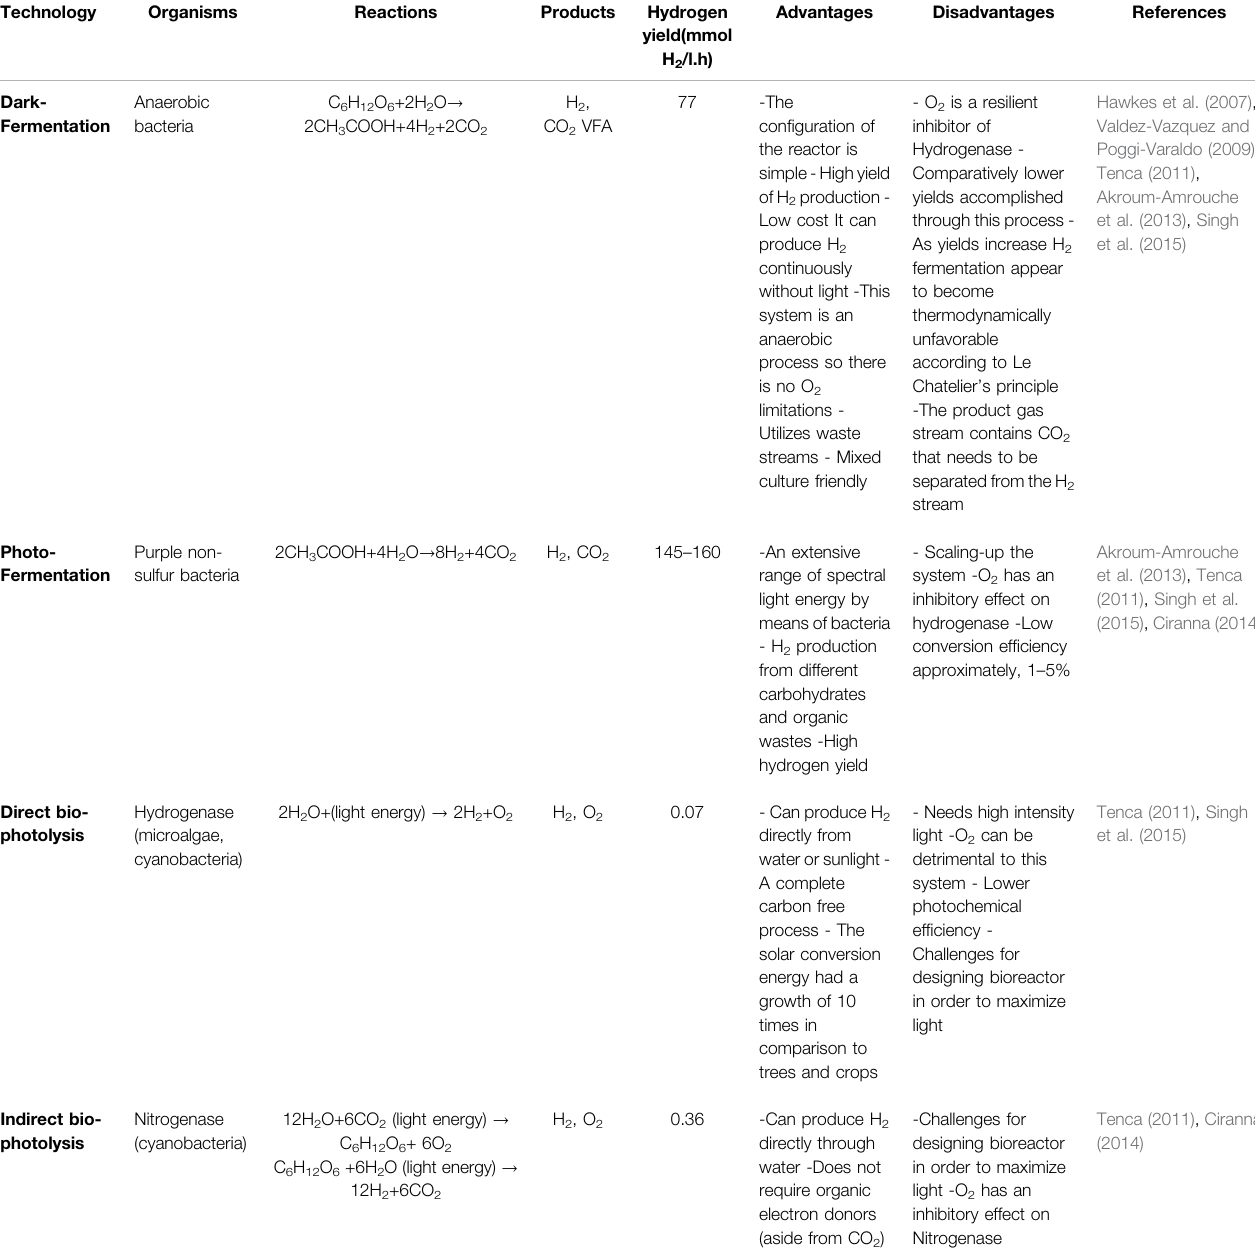
TABLE 4 | A Comparison of different types of biological hydrogen production